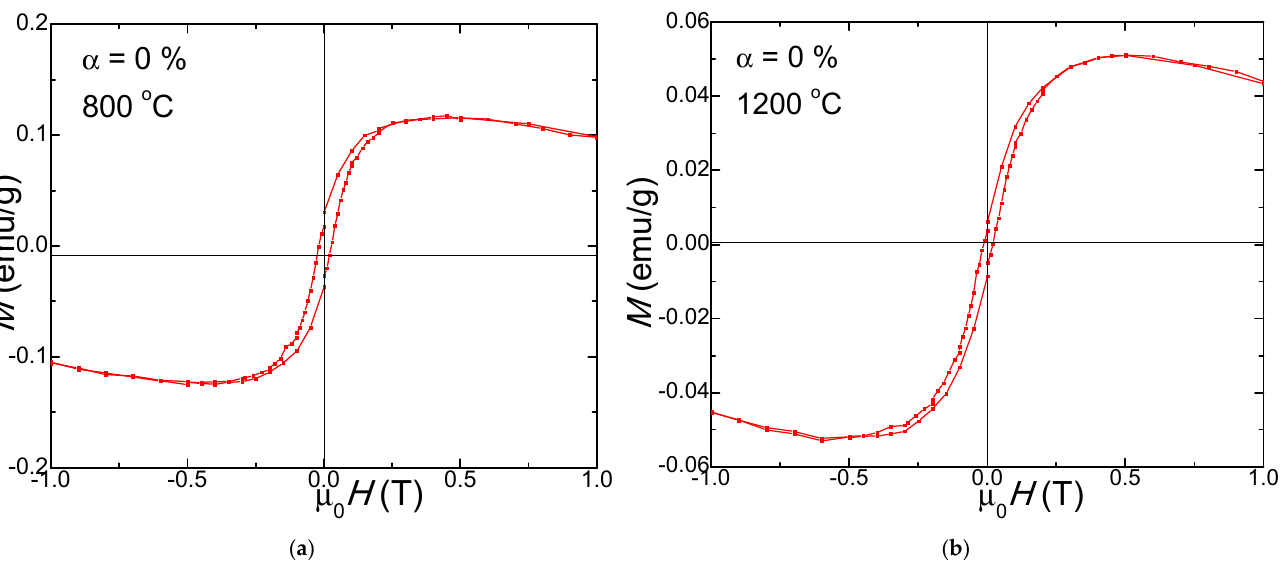
Figure 6. Particle size distributions for (Co 0.4 Zn 0.4 Ni 0.2 Fe 2 O 4 ) α (SiO 2 ) 100 − α samples ( α = 25–100%) an- nealed at 1200 °C.